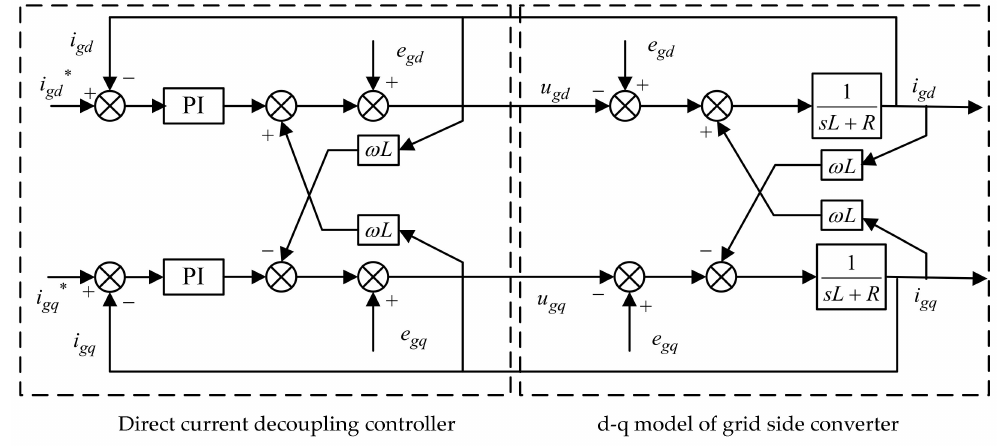
Figure 3. Schematic diagram of current decoupling control.